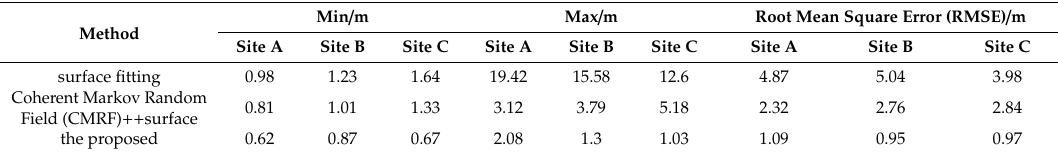
Table 2. Accuracy evaluation